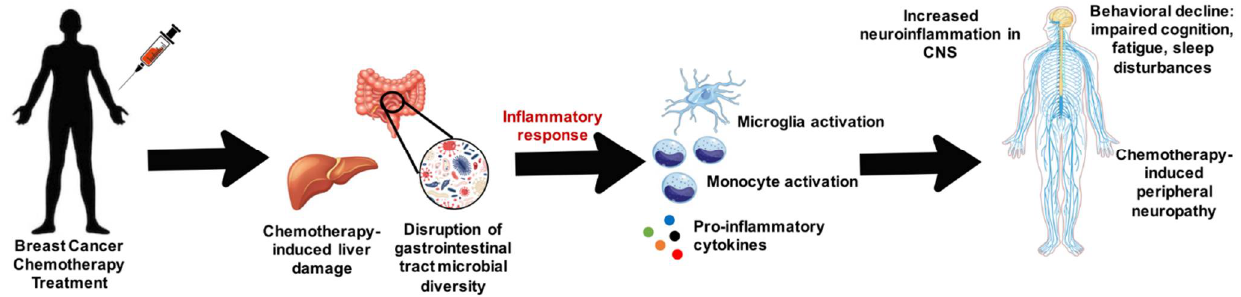
Figure 1. Overview of how breast cancer chemotherapy can damage the liver and disrupt microbial diversity within the gastrointestinal tract and cause inflammatory mediated damage on the nervous system.